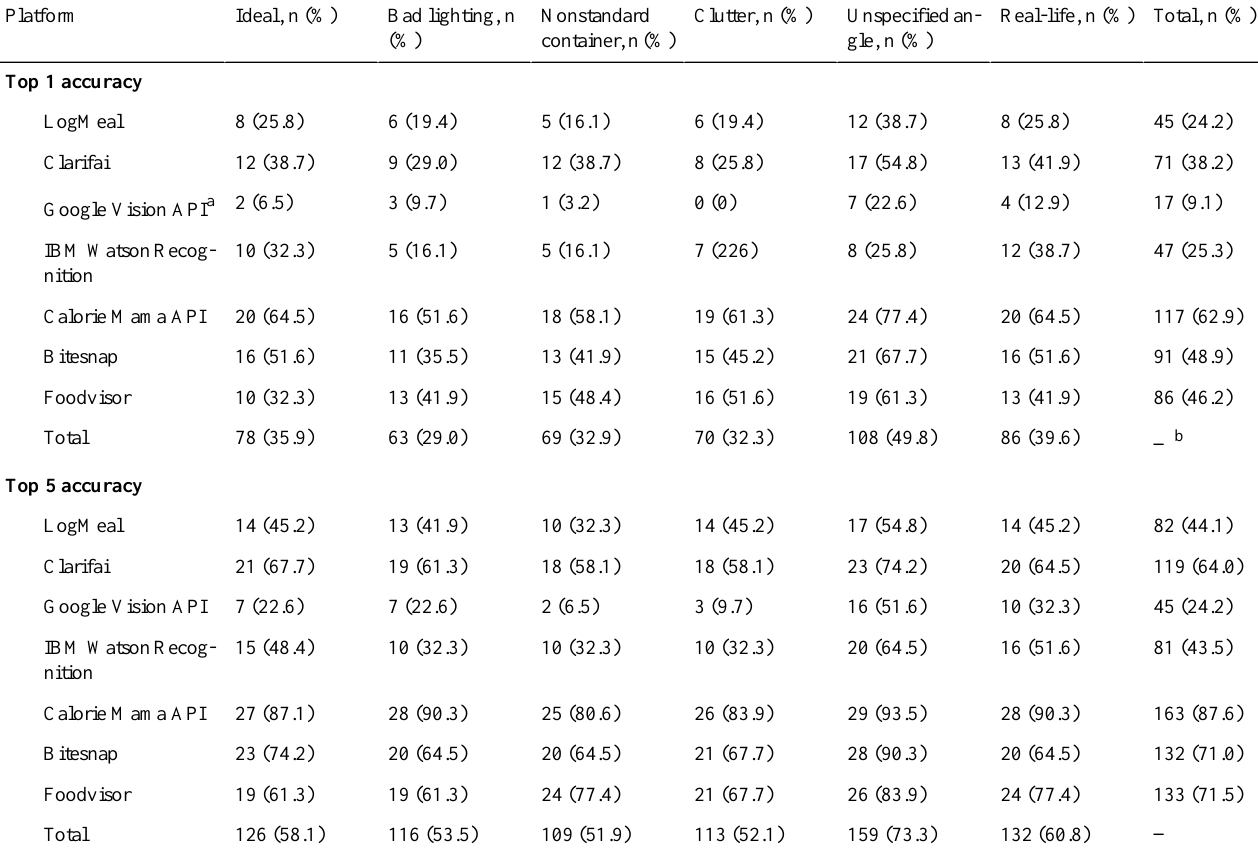
Table 3. Accuracy of food recognition among different platforms and different settings (n=31/setting).